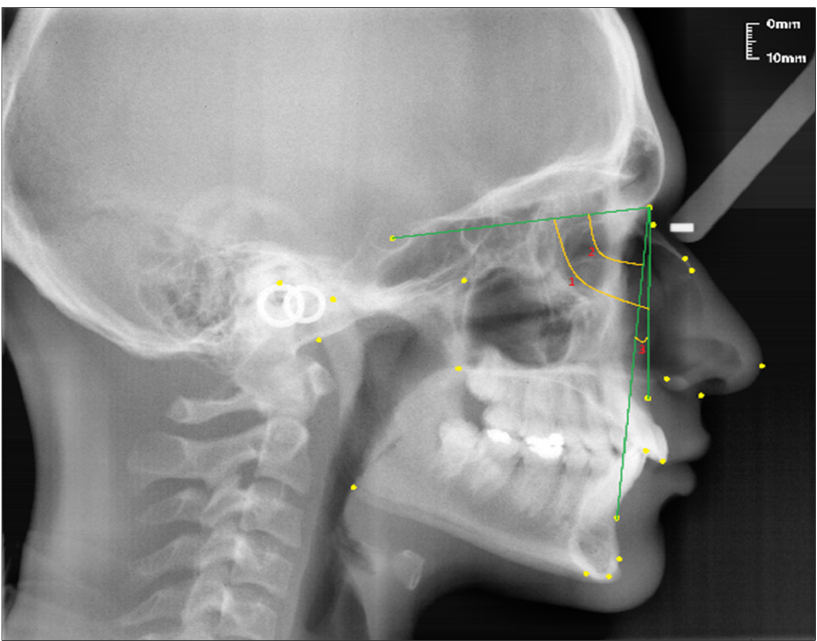
Figure 4. Angular craniofacial skeletal measurements used in the study.